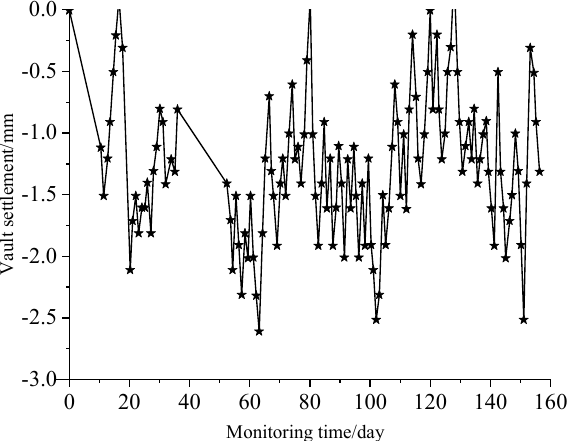
Figure 14. Vertical displacement of the tunnel vault.